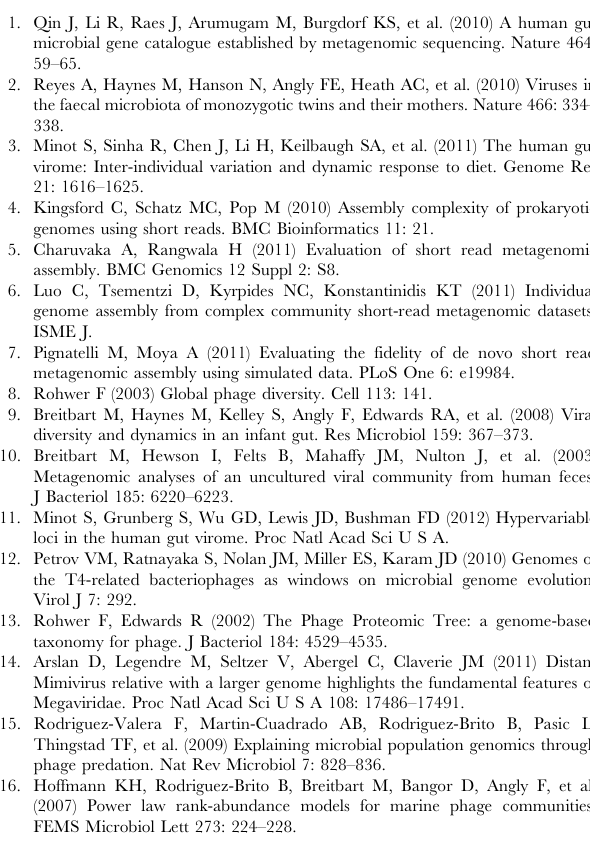
boxes above each plot. The success of HPV reconstruction was measured as the length of the longest HPV-matching contig as a proportion of the total HPV length (vertical axis). The horizontal axis indicates the three assembly methods used. Three indepen- dent random samples were created for each level of coverage, and the assemblies using the same dataset are connected with a line. (PDF) Figure S3 One additional example of phage cassette. Contigs are shown as horizontal black lines, ORFs on those contigs are shown by black arrows above and below those lines, and the organization of those ORFs into protein-coding families is shown with colored boxes. The subject that each contig was assembled from is shown on the left of each panel. When a protein-coding family was functionally annotated according to its similarity with the CDD, that annotation is listed in the